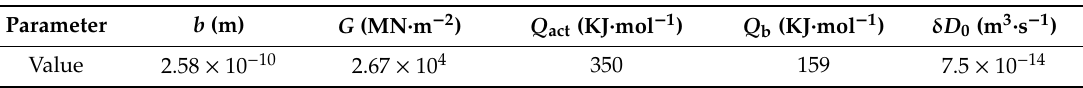
Table 1. The parameters for Cellular automaton (CA) simulation in FeMnSiCrNi shape memory alloy